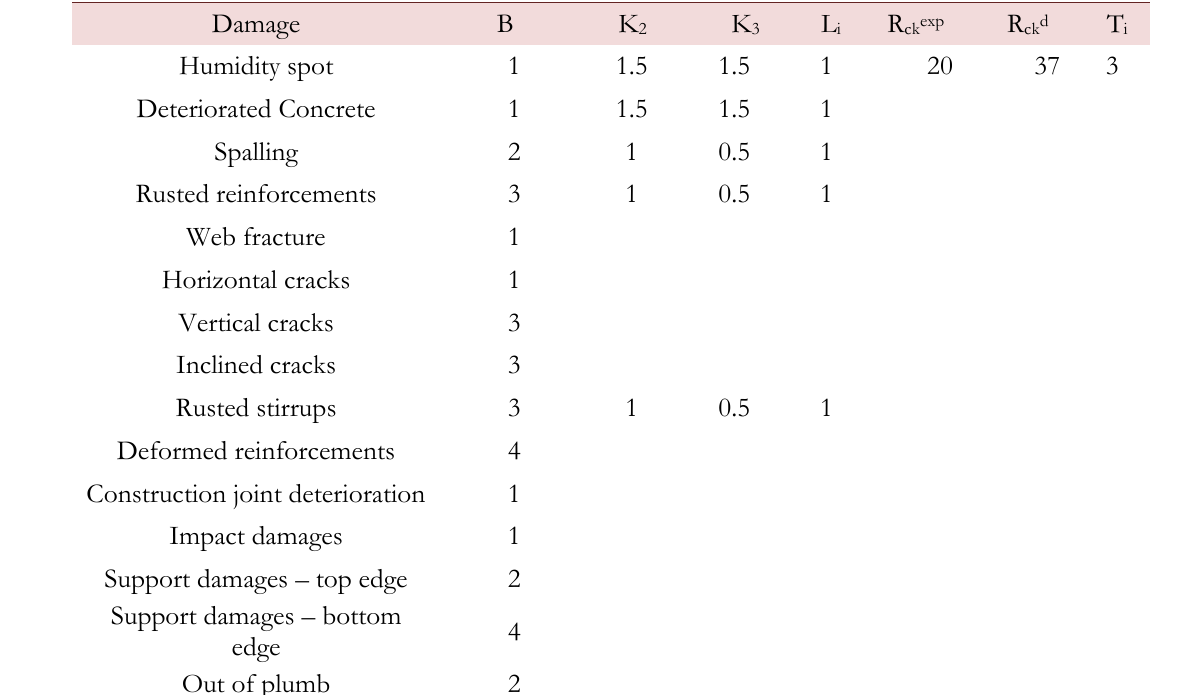
Table 6: Abutment Damage identification form for Bridge P08.